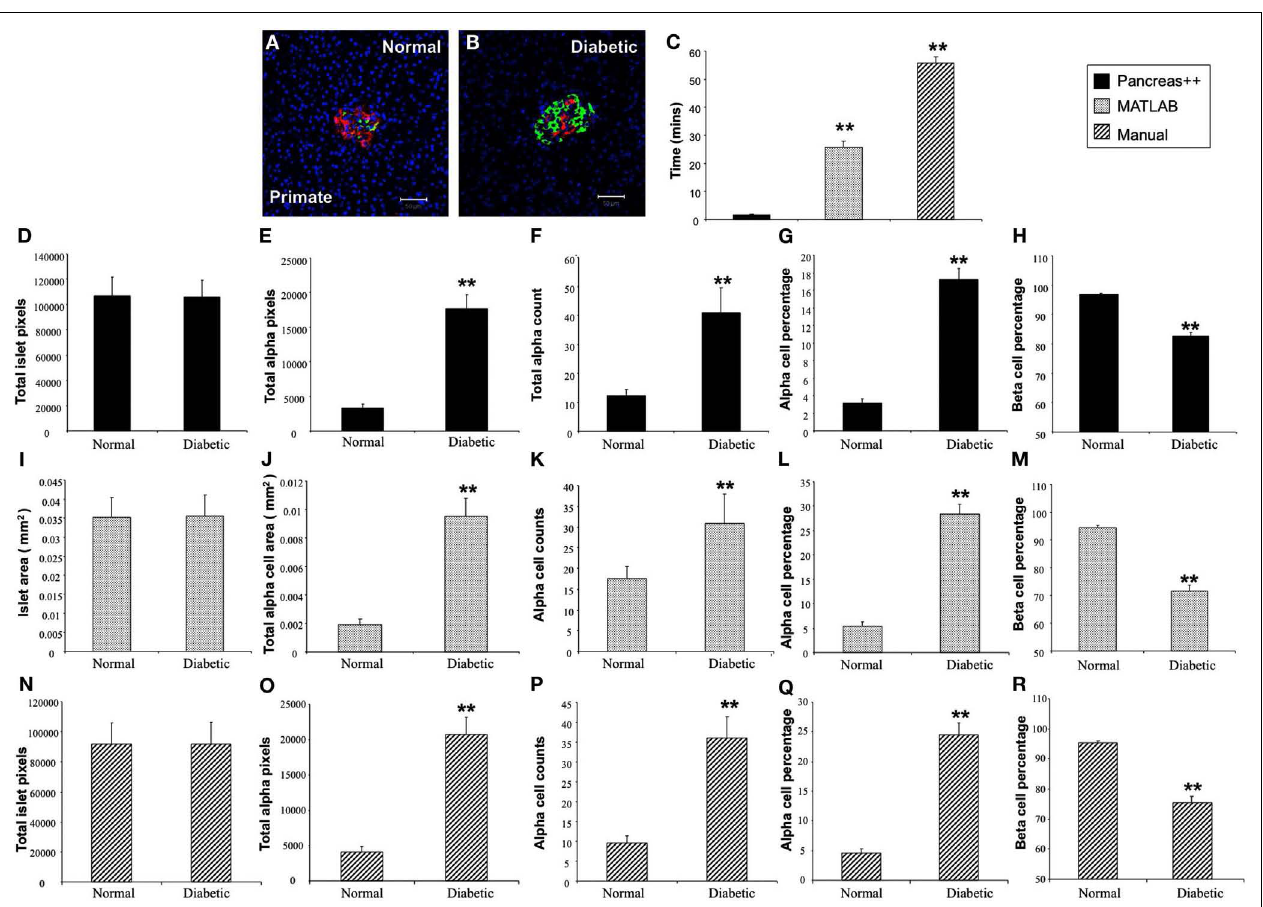
Islet area (I) ; total alpha-cell area (J) ; total alpha-cell numbers (K) ; alpha-cell percentage (L) ; beta-cell percentage (M) of normal and diabetic primate analyzed by MATLAB showed the same pattern as the results analyzed by Pancreas ++ . Also islet area (N) ; total alpha-cell area (O) ; total alpha-cell numbers (P) ; alpha-cell percentage (Q) ; beta-cell percentage (R) of normal and diabetic primates analyzed by manual methods showed the same pattern as the results analyzed by Pancreas ++ . Data are means ± SEM. ** p ≤ 0.01, n =